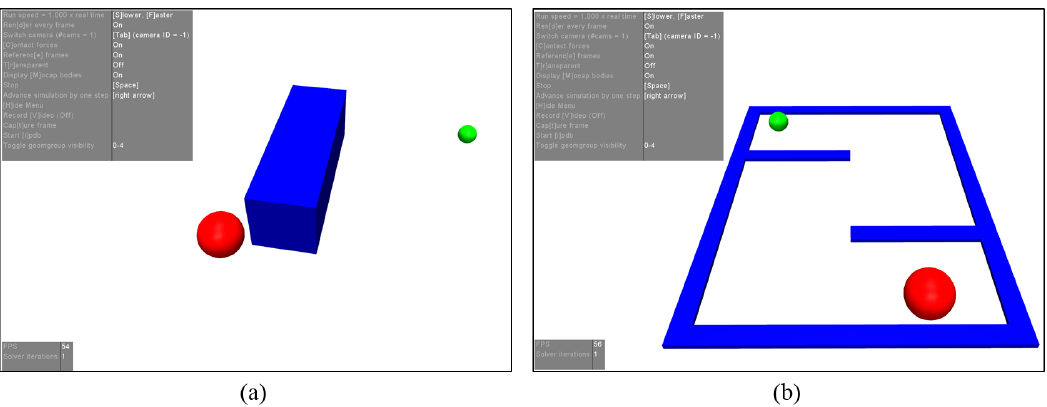
Figure 6. Task-relevant simulated environments generated based on our proposed method. ( a ) Manipulation task. ( b ) Navigation task. The blue objects are the obstacles, solid red balls are the virtual agents, and green balls denote the target objects (positions). The gray areas illustrate control information of the constructed environment. Best viewed in color.